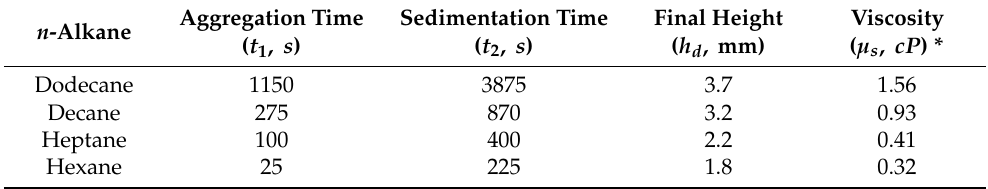
Table 3. Analysis Table 3. Analysis parameters.